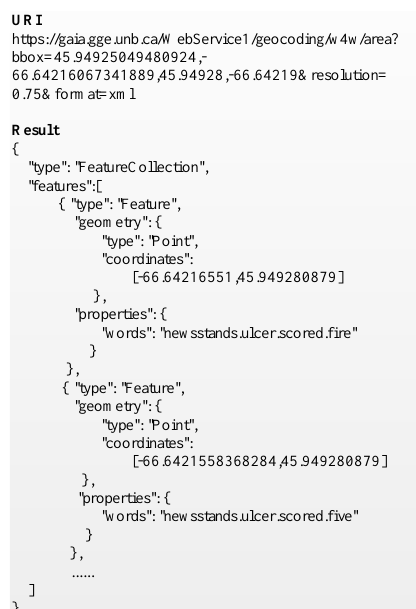
Table 9. Algorithm of converting coordinates to four-word code